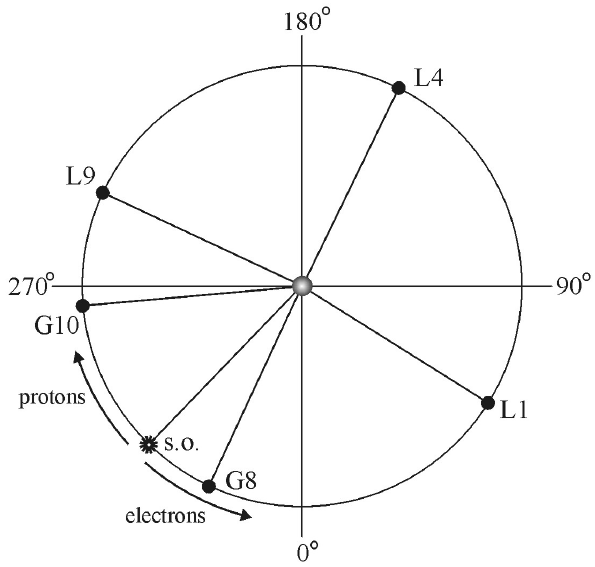
Fig. 1. The position of the substorm onset and the satellites for the moments of the observations of the events.